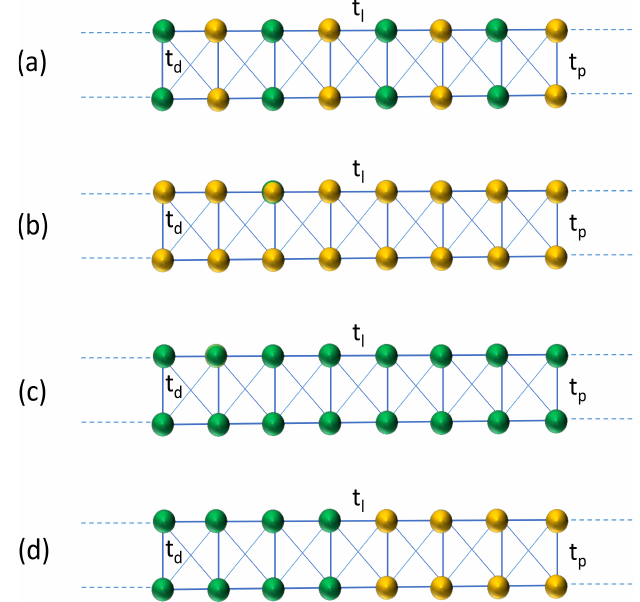
Figure 1. (Color online). Schematic diagrams of non-Hermitian Aubry–André–Harper ladders following the four different arrangements of the imaginary site energies those are respectively presented in ( a ), ( b ), ( c ) and ( d ). The green ball corresponds to the lattice site where negative imaginary energy (loss term) is added, while the orange ball indicates the site where positive imaginary energy is included (gain term). The parameters t l and t p refer to the intra- and inter-strand hopping integrals, respectively, and t d describes the diagonal hopping between the two